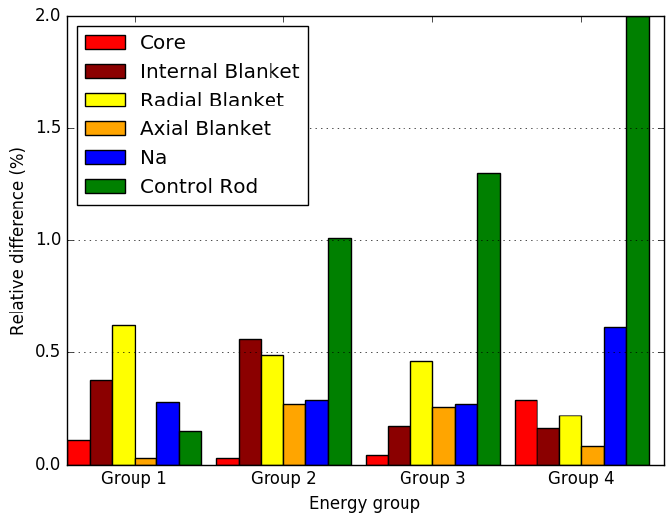
Figure 18. Comparison of region-averaged flux from reference and AZTRAN Model 3 Case 1.